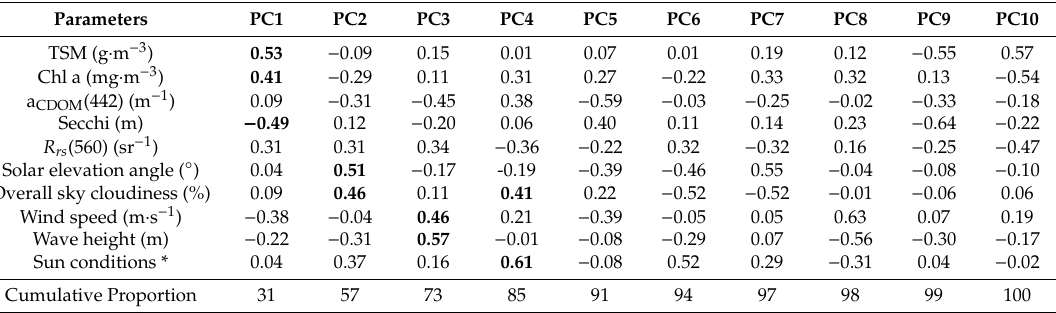
Table 2. Principal Component Analysis (PCA) components (PC1–PC10) and contribution by measured parameters. Parameters with highest contribution to first four principal components are marked in bold. The lowest row shows the cumulative proportion (%) of each component to the total variation. Parameters